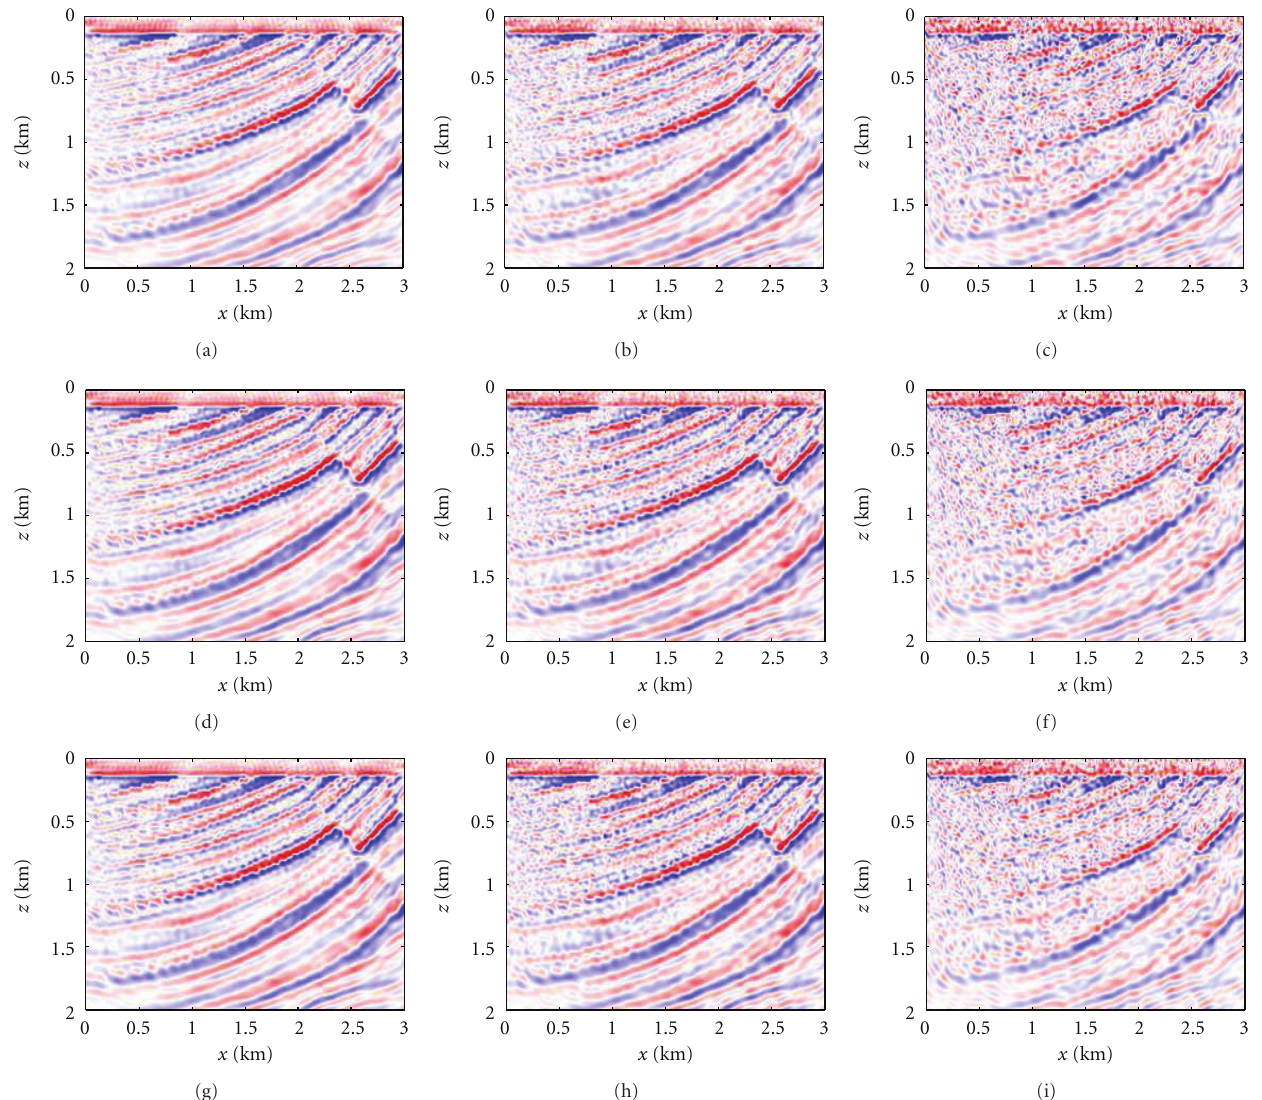
Figure 11: Inversion result for the SA approach with limited averaging ( n = 10) for various batch sizes and noise levels. The rows represent di ff erent batch sizes K = 1, 5, 10, while the columns represent di ff erent noise levels: no noise, SNR = 20 dB, and SNR = 10dB. We obtain good results with K = 1, and the quality does not improve dramatically for larger batch sizes, except for the highest noise